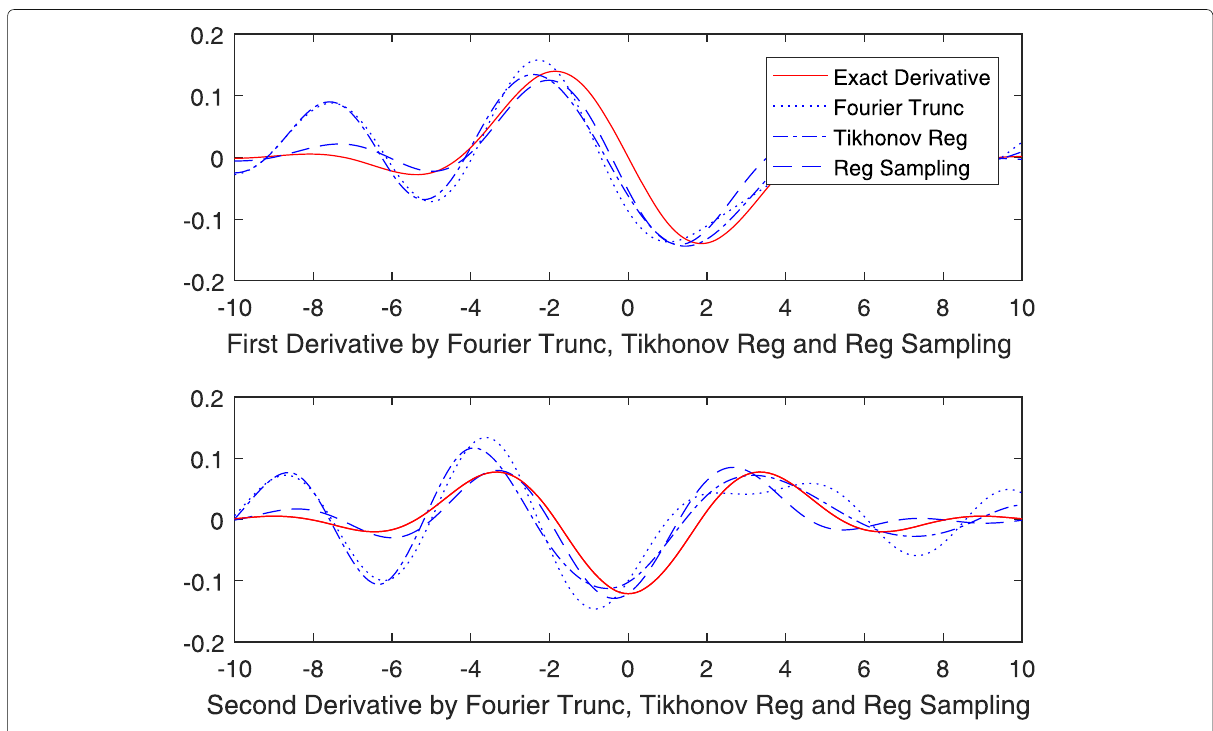
Fig. 8 The simulation results for the uniform noise in Example 4